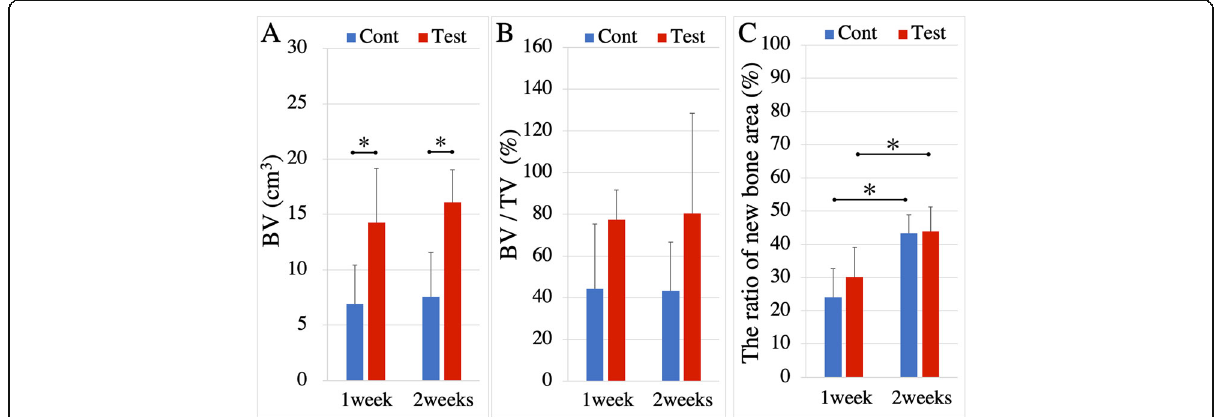
Fig. 3 BV, BV/TV, and the ratio of new bone area change in each group. a BV were shown and significant differences were found. b BV/TV were shown and no significant differences were found between groups at the same time points. c The ratio of new bone area change were shown and no significant differences were found. * p <